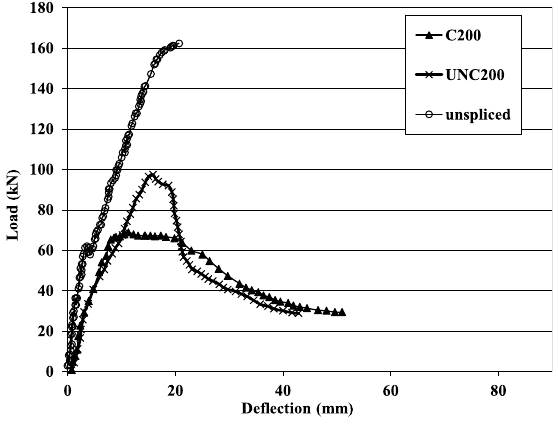
Figure 6. Load-Deflection curves for beams with 8 mm stirrups spaced @